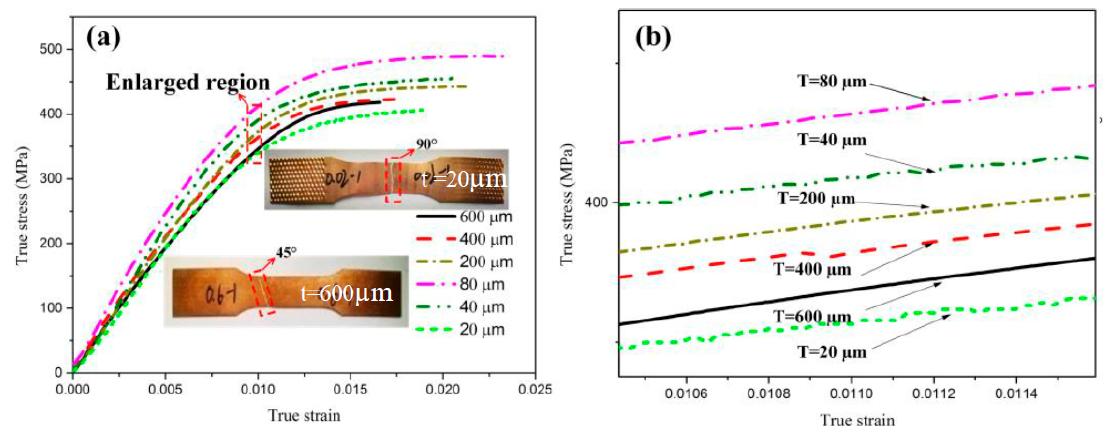
Figure 3. Experimental results. ( a ) Stress–strain curves, ( b ) enlarged region. The fractography of tensile samples with thicknesses of 600 µm and 20 µm after uniaxial tensile test is shown in ( a ).